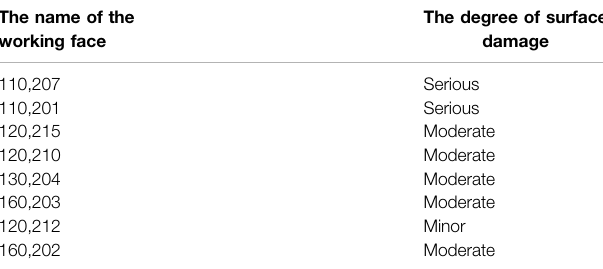
TABLE 4 | The degree of surface damage of the working face in the study